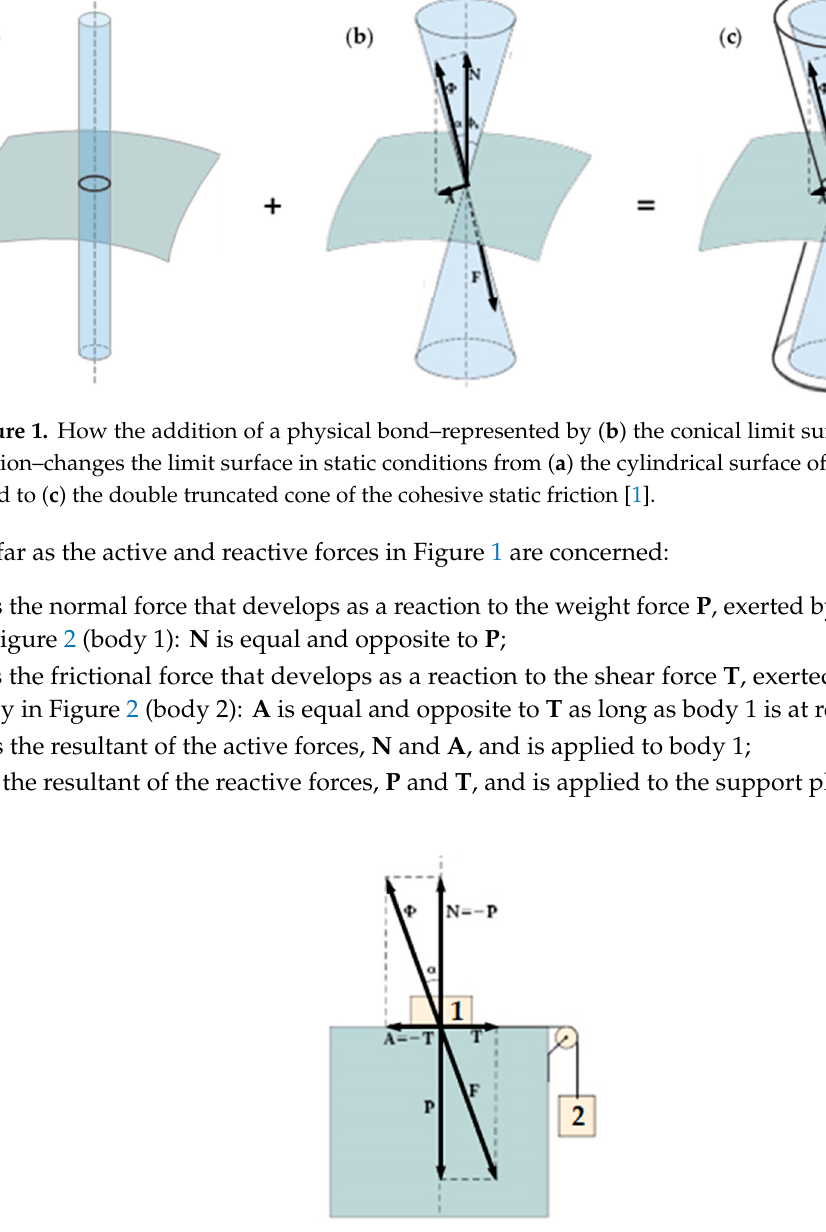
Figure 2. Body 1 at rest under the combined action of its weight force and the shear force provided by body 2: Active and reactive forces developed on the support plane.